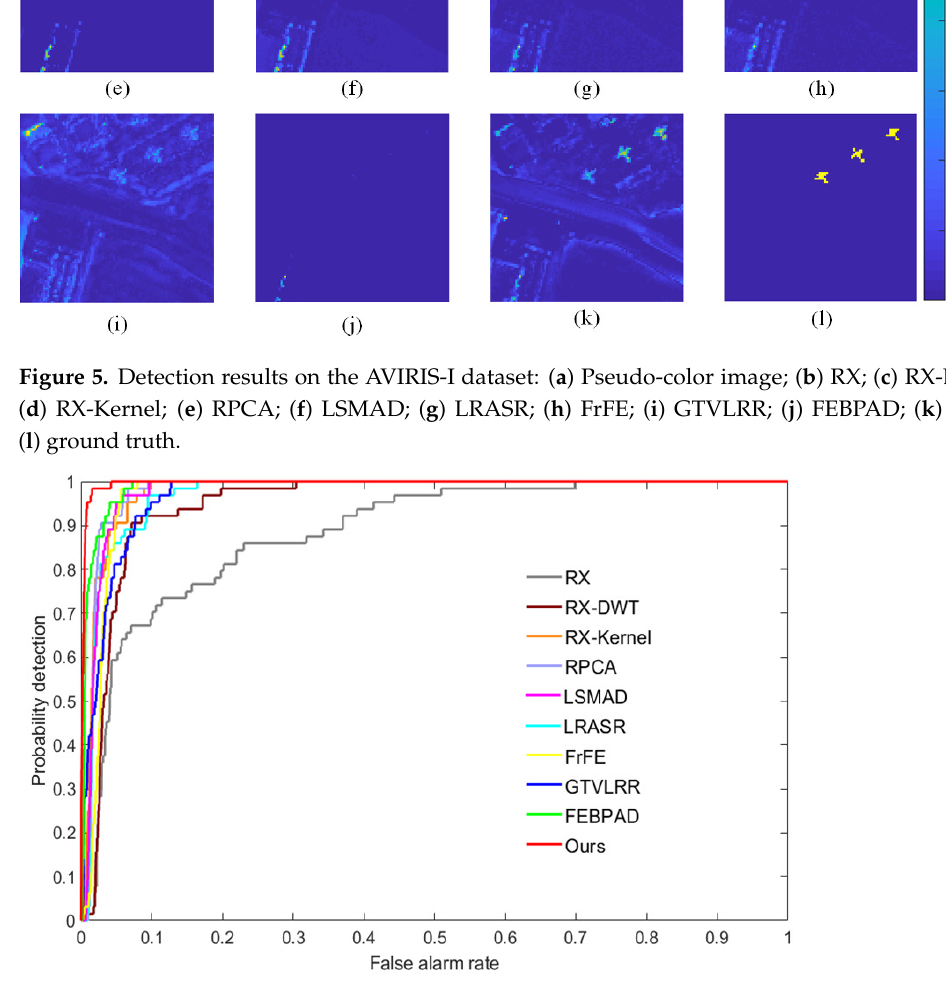
Figure 6. ROC curves of anomaly detectors on the AVIRIS-I